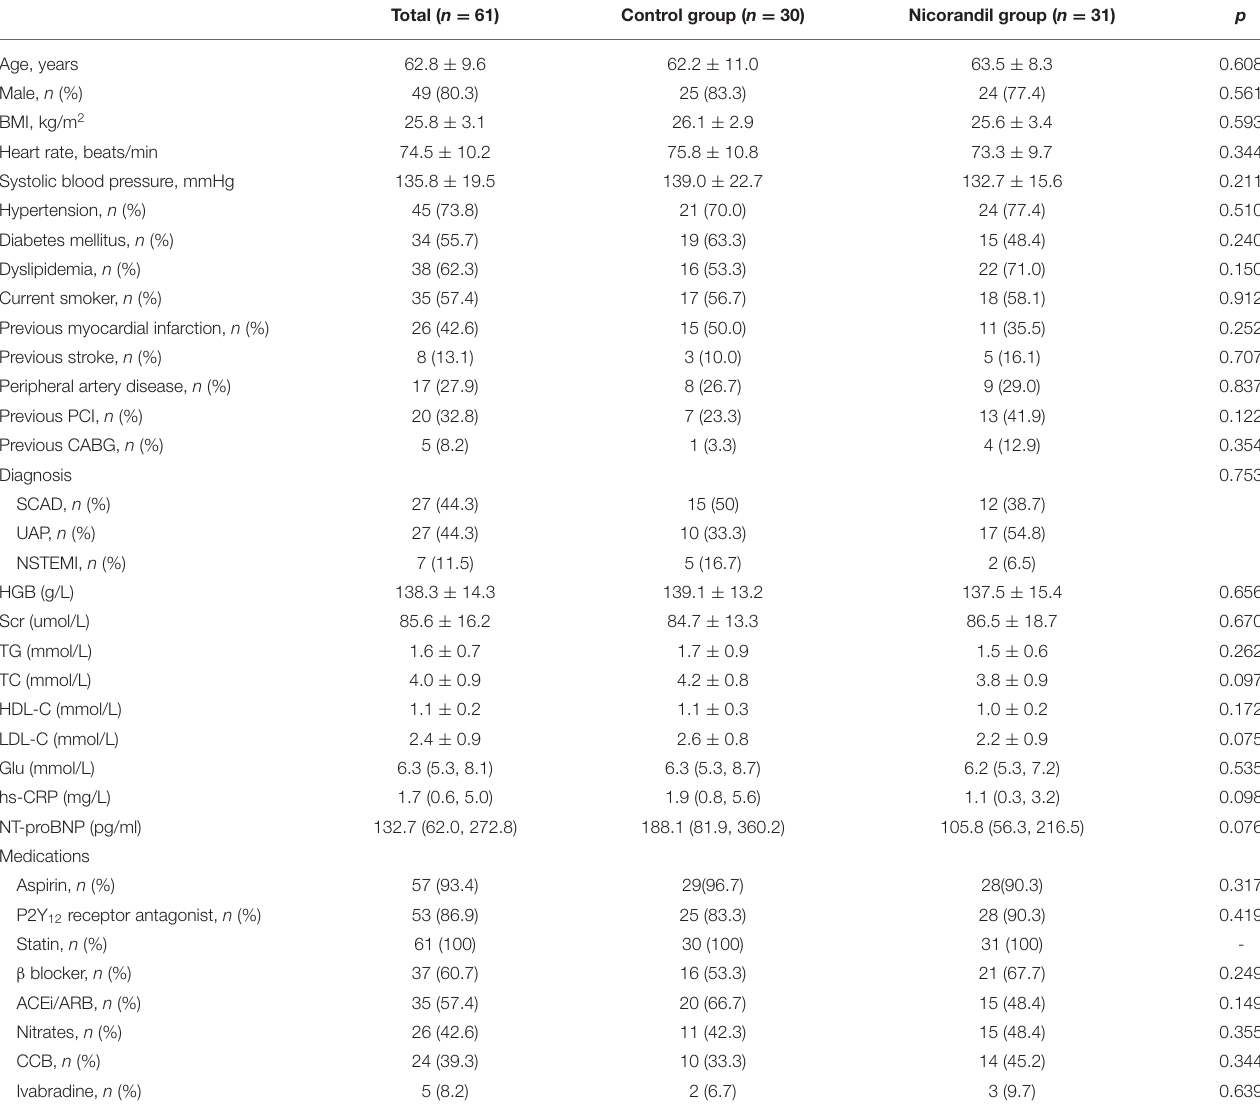
TABLE 1 | Demographic and clinical characteristics of the nicorandil group and the control